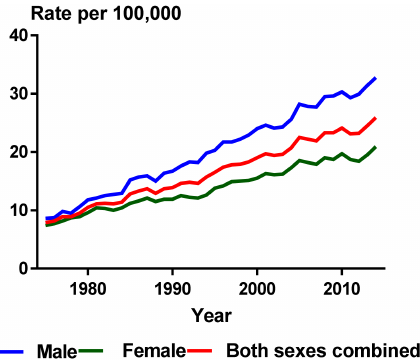
Fig. 1. Incidence of MM in the United States from 1975 to 2014.